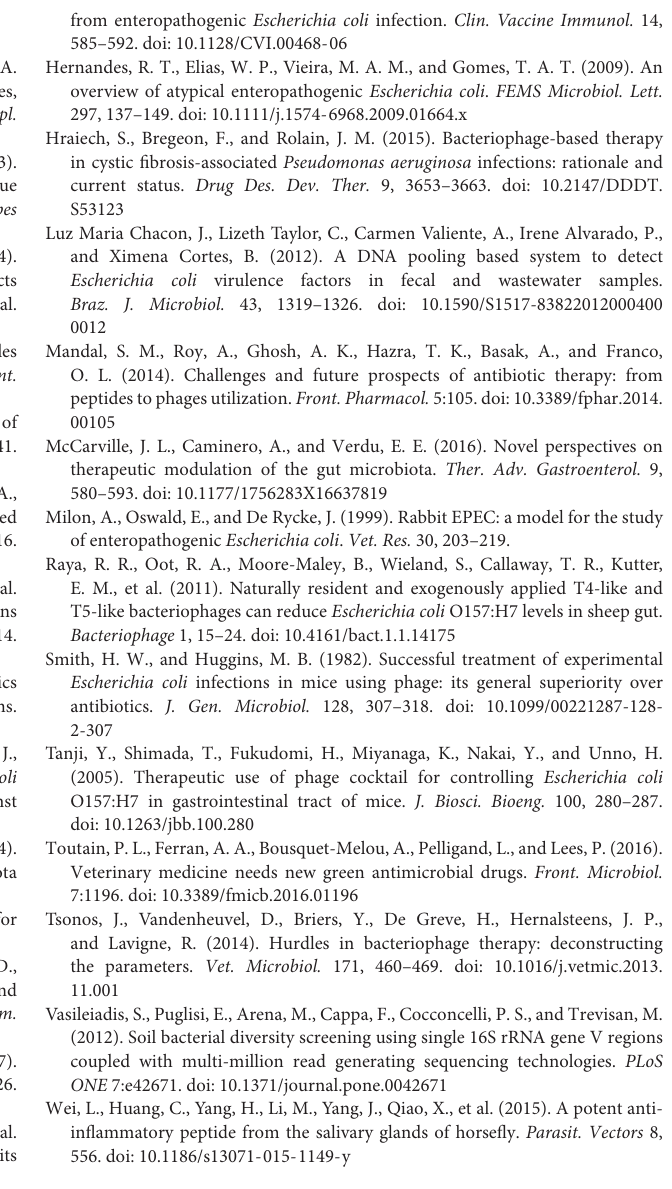
TABLE S1 | Total OTUs and tags of 16 mixed samples in four